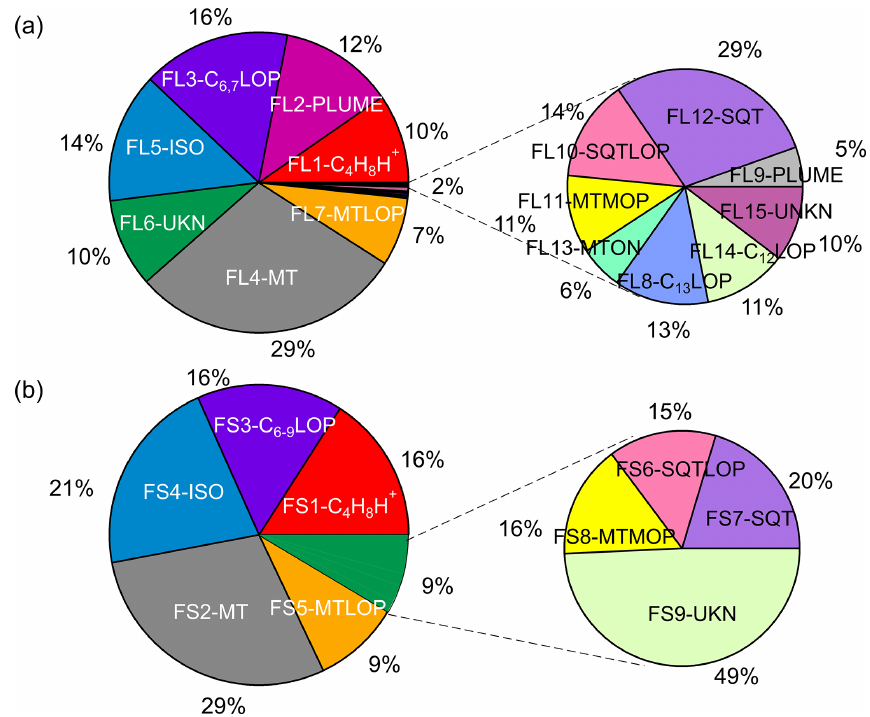
Figure 12. Average mass contributions of various identified factors in total measured organic vapors (a) in the Landes forest and (b) at the SMEAR II station. The common sources apportioned at both sites are presented in the same color in (a) and (b) . FL: factors in the Landes forest; FS: factors at the SMEAR II station; C 4 H 8 H + : C 4 H 8 H + ion-related; PLUME: a plume event; C 6 , 7 LOP: C 6 and C 7 lightly oxidized products; C 6 − 9 LOP: C 6 –C 9 lightly oxygenated compounds; MT: monoterpenes; ISO: isoprene and its oxidation products; UKN: